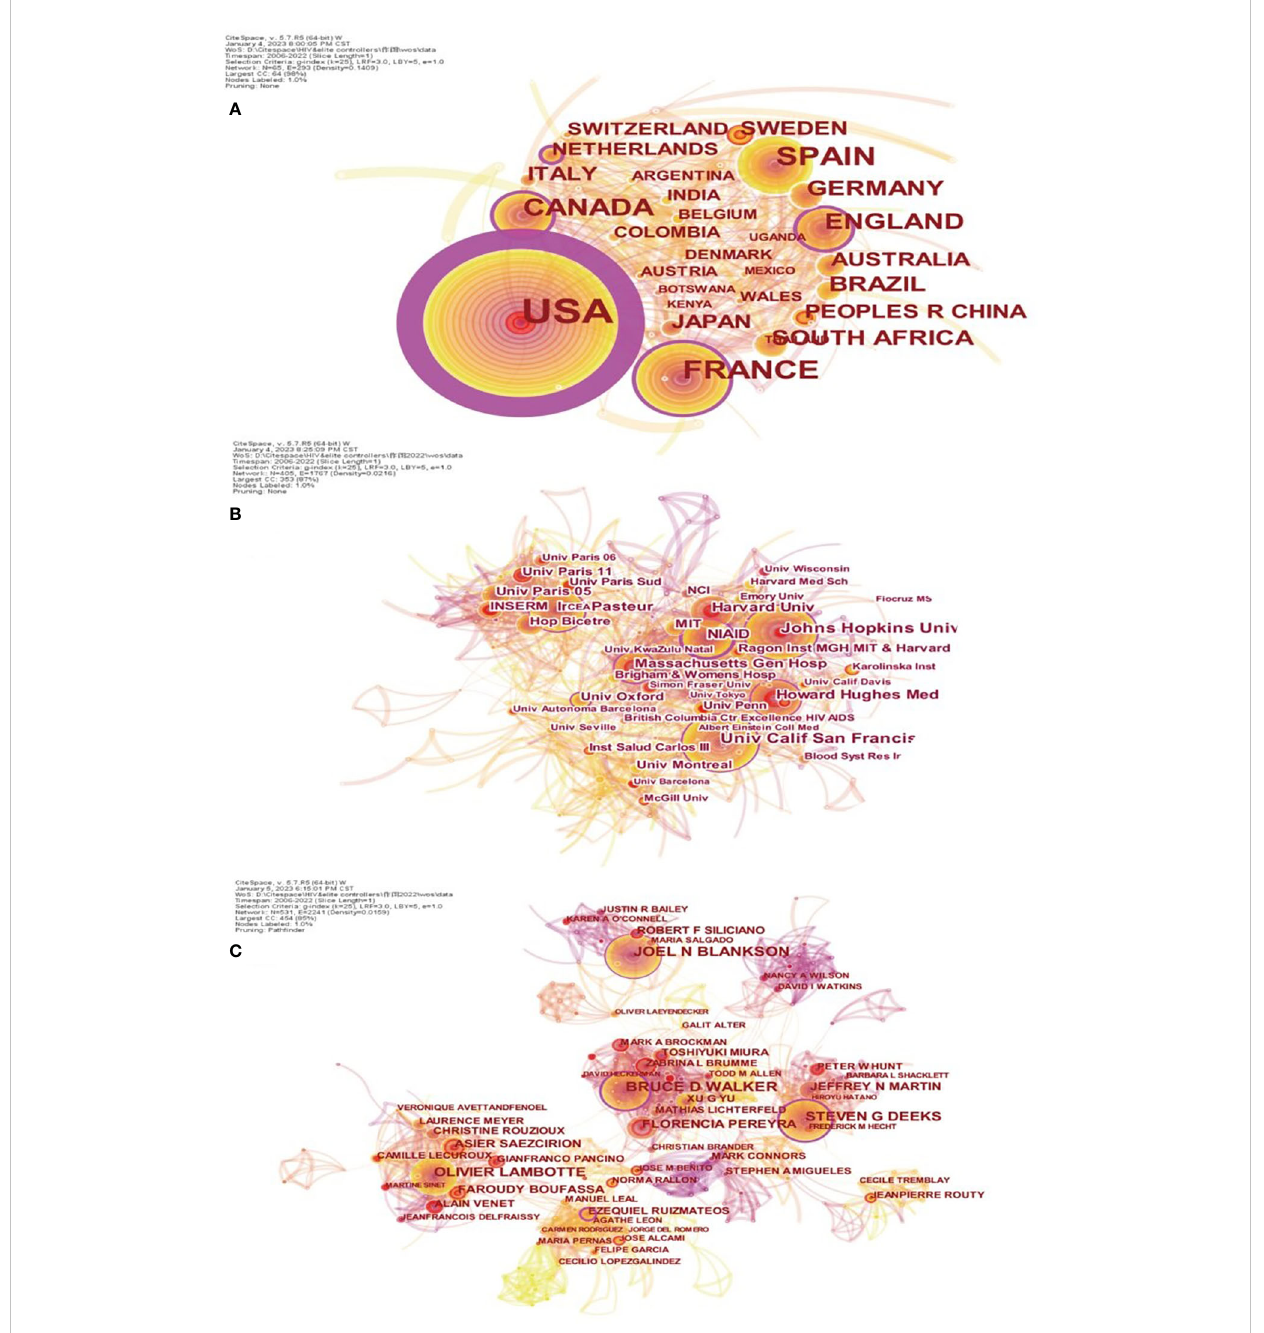
FIGURE 2 Citespace network map of publication distribution in the elite controller fi eld. (A) The publication distribution and cooperation of 65 countries/ regions. (B) The publication distribution and cooperation of 405 institutions. (C) The publication distribution and cooperation of 531